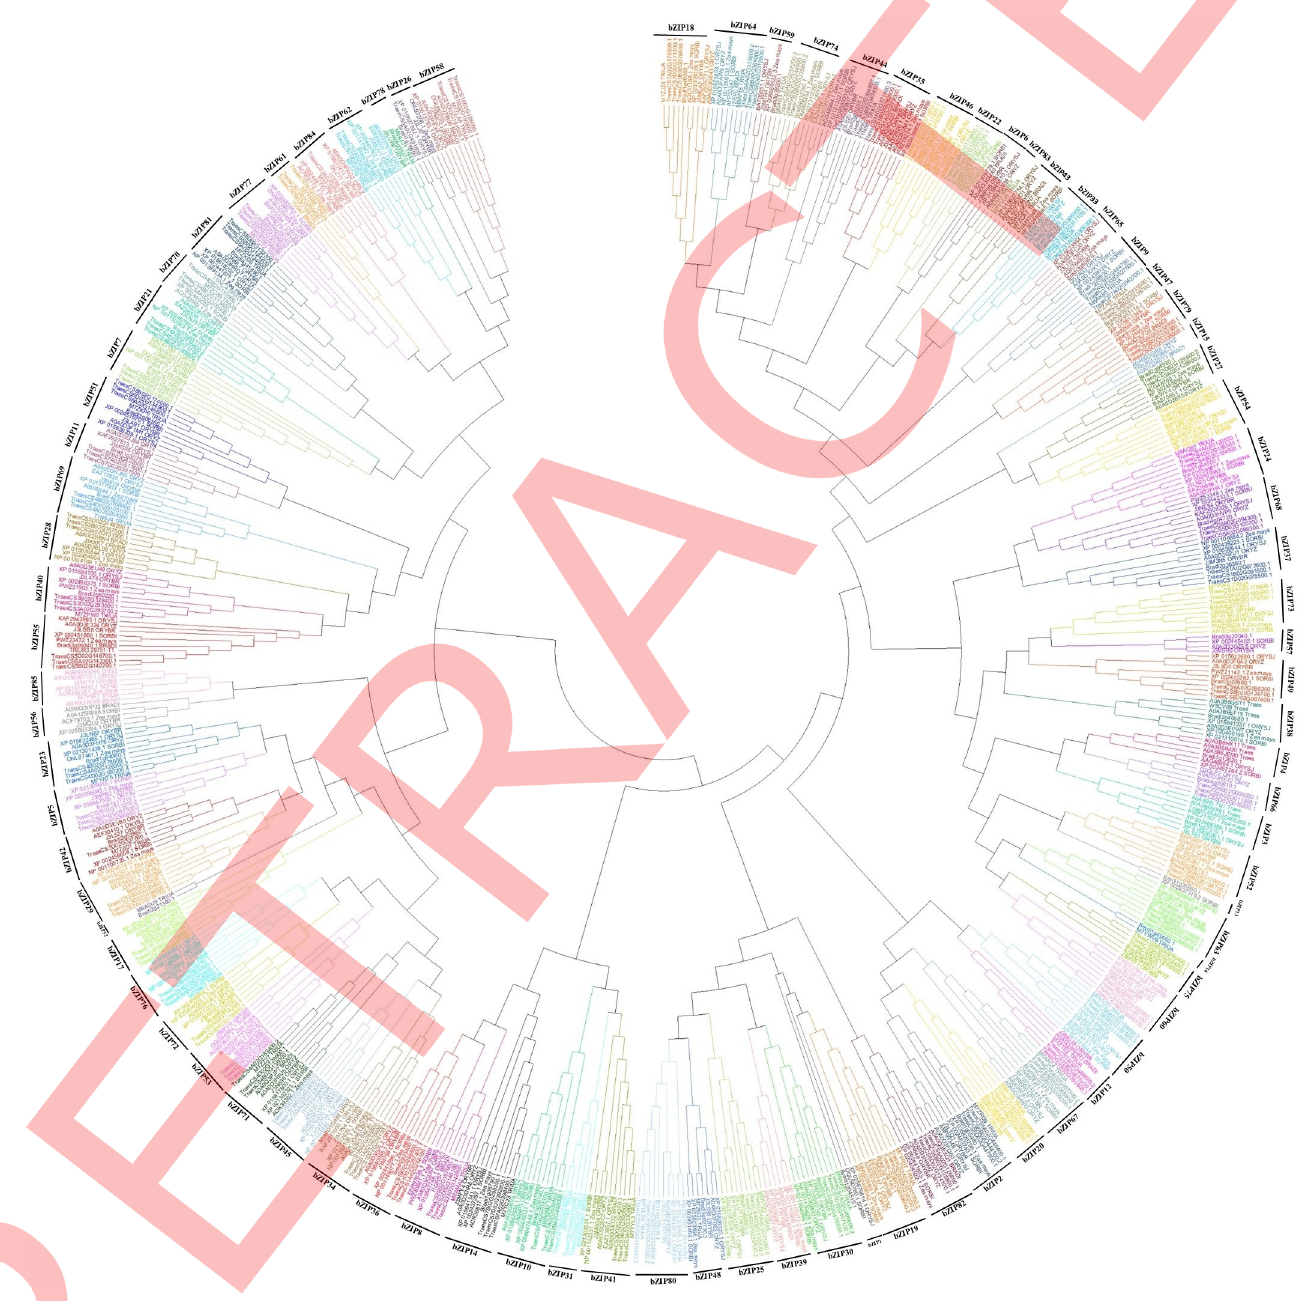
Fig 1. Phylogenetic analysis using Maximum Likelihood method. The tree with the superior log likelihood (-173413.62) is shown in the figure. The analysis of bZIP involved 662 amino acid sequences. There were a total of 1890 positions in the final dataset.